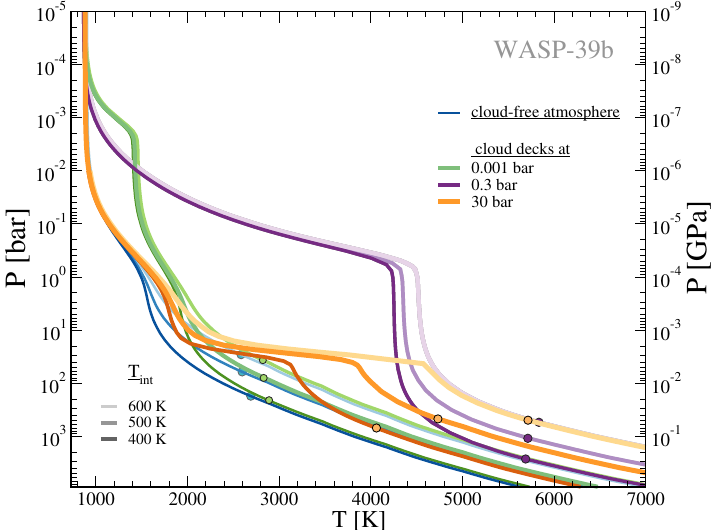
Figure 9. Atmospheric P – T profiles of WASP-39b for finite T int values of 400, 500, and 600 K for three decks located at 0.001 (green), 0.3 (purple), and 30 (orange) bar as well as the cloud-free atmosphere (blue). Circles mark the transition between atmosphere and adiabatic